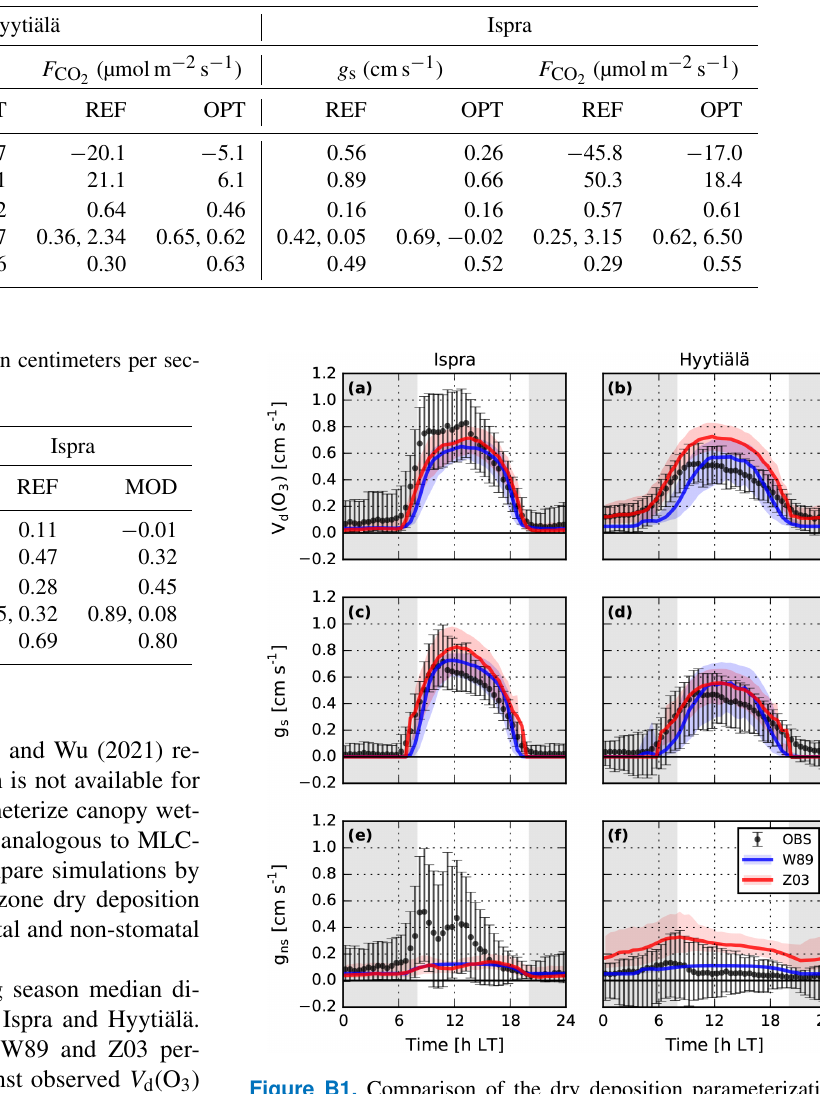
Figure B1. Comparison of the dry deposition parameterizations W89 (Wesely, 1989) and Z03 (Zhang et al., 2003) against the ob- served dry deposition velocity (a, b) and observation-inferred stom- atal conductance (c, d) and non-stomatal conductance (e, f) for Ispra and Hyytiälä (left and right panels, respectively). Lines and shaded areas (points and whiskers) show April–September median and in- terquartile range of the simulations